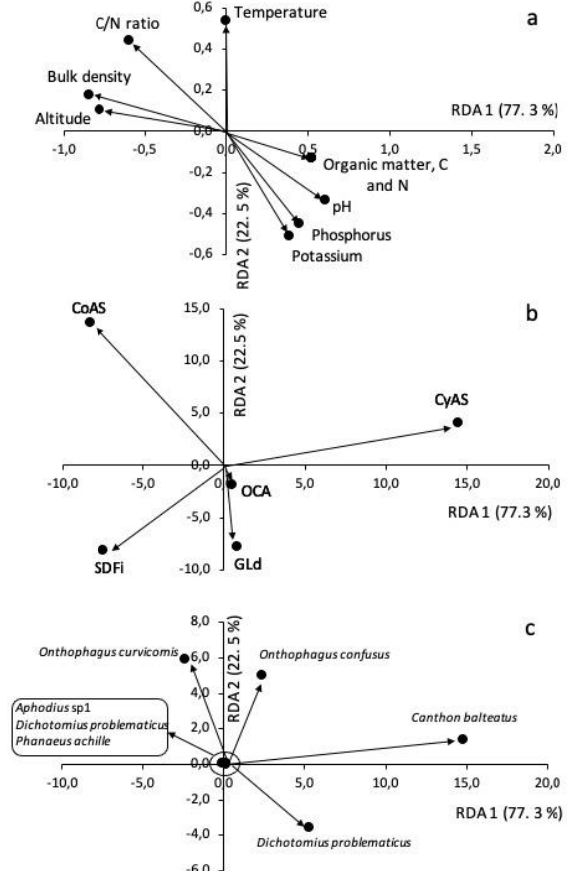
Figure 4. Scores of the soil and environmental variables ( a ), land uses ( b ), and dung beetle species ( c ) of the redundancy analysis (components: RDA 1 and RDA 2). Note the different scales of RDA 1 and RDA 2.